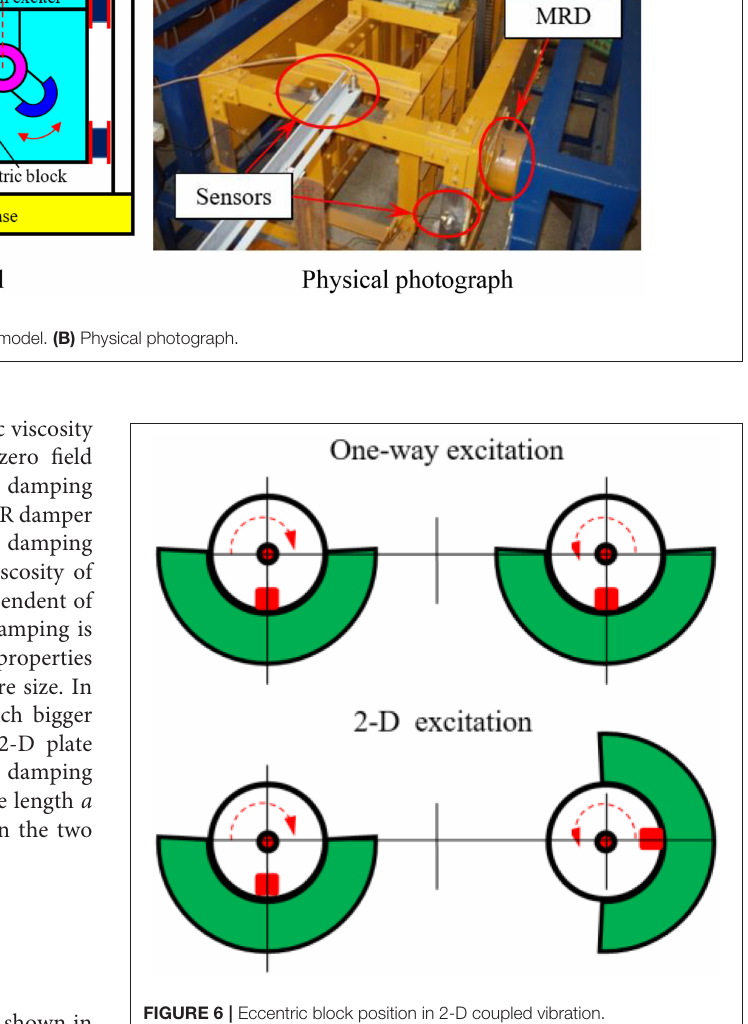
FIGURE 6 | Eccentric block position in 2-D coupled